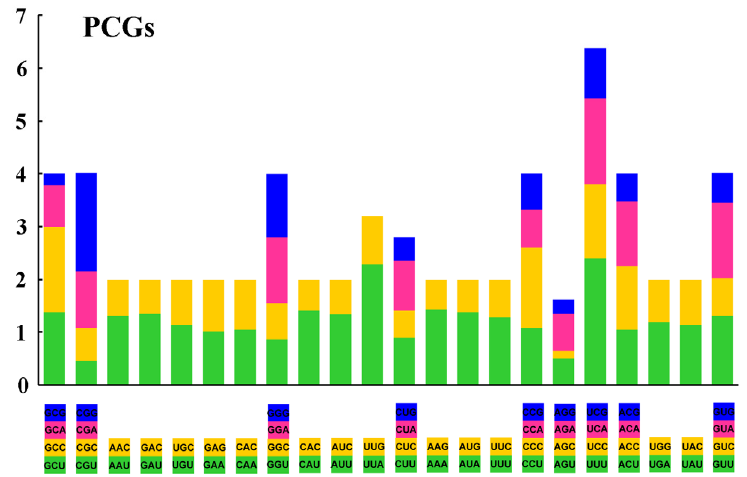
Figure 2. The relative synonymous codon usage (RSCU) in the mitogenome of S. fasciata . PCGs represent protein-coding genes.